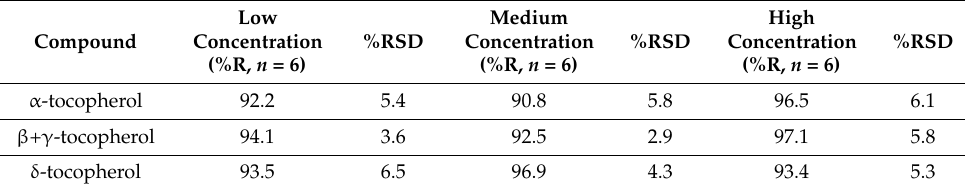
Table 2. Recovery (%R) rates for the evaluation of the repeatability.